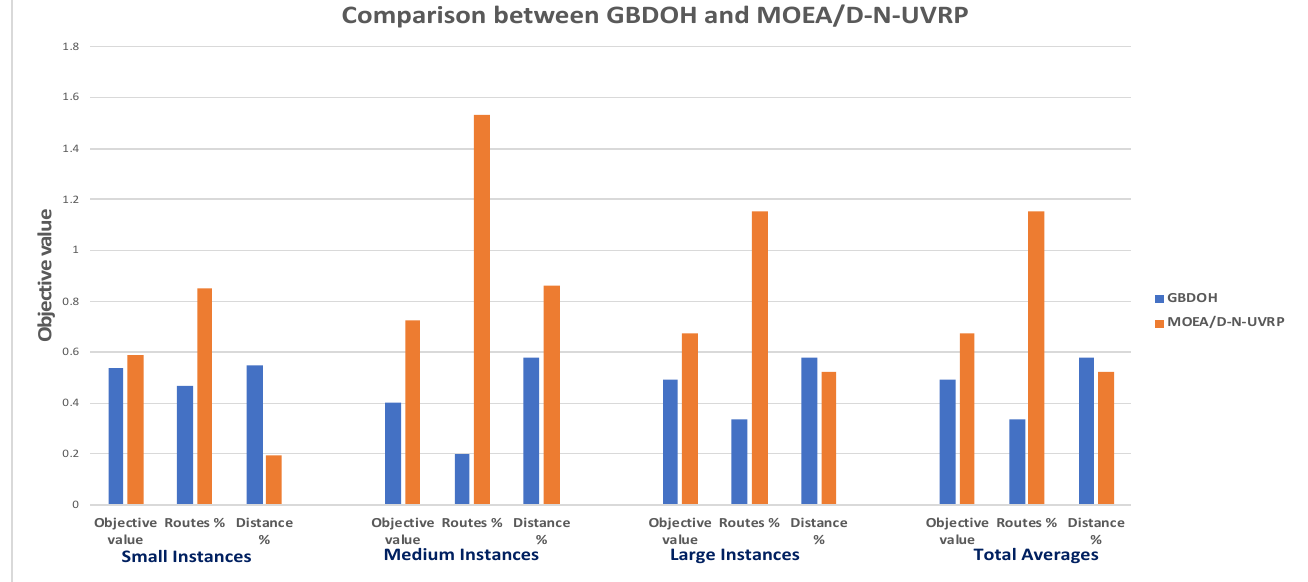
Figure 4. Comparison between the average results of the GBDOH and MOEA/D-N-UVRP on each group size of instances in terms of objective value, percent deviation from the value of the baseline routes, and percent deviation from the value of the baseline distance.